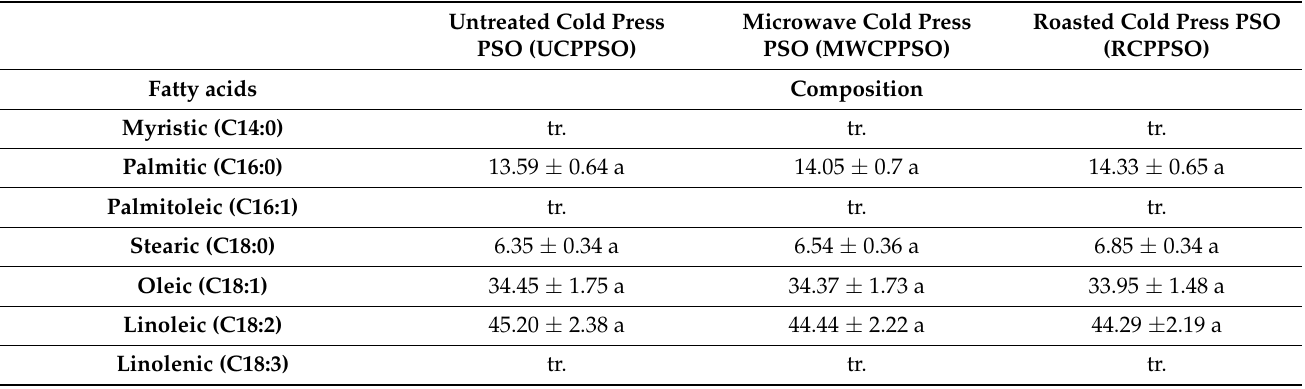
Table 1. Fatty acid (%), sterol (mg/kg oil), and tocopherol compositions (mg/kg oil), and oxidative stability of cold pressed pumpkin seed oils